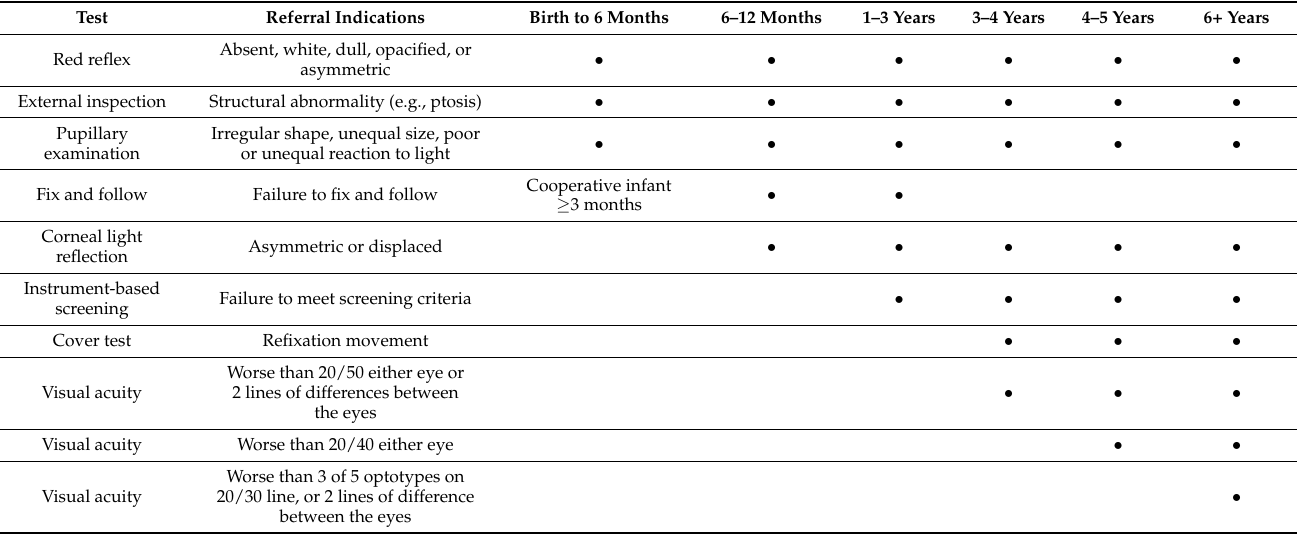
Table 1. Pediatric Vision Screening Tests and Referral Indications by